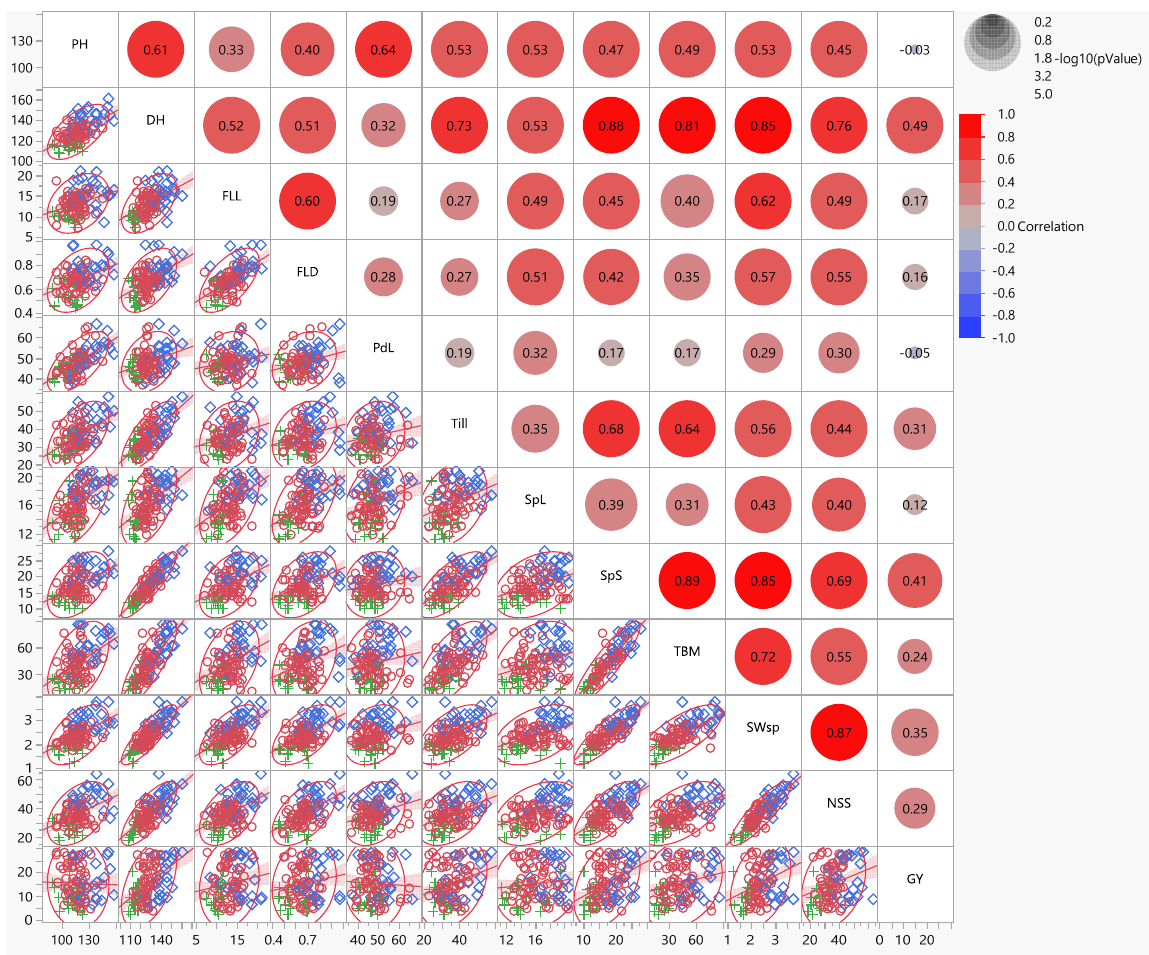
Figure 2. Scatterplot matrix to visualize several attributes by pairwise dependencies of twelve phenotypic traits. The upper triangle matrix is representing correlations among twelve studied traits. The lower triangle matrix is the revelation of bivariate density distribution with ellipses between each pair of attributes. The legends at the top right corner of the color gradient (red to blue), and the size of circles show the amount of correlation and log ( p ) values for the significance threshold, respectively.